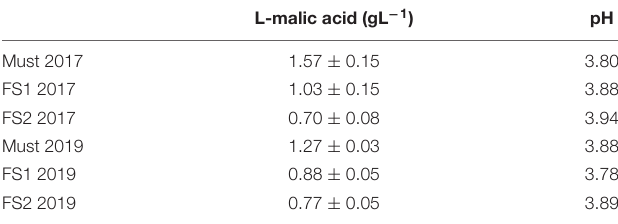
TABLE 2 | L-malic acid concentrations and pH evolution in the samples